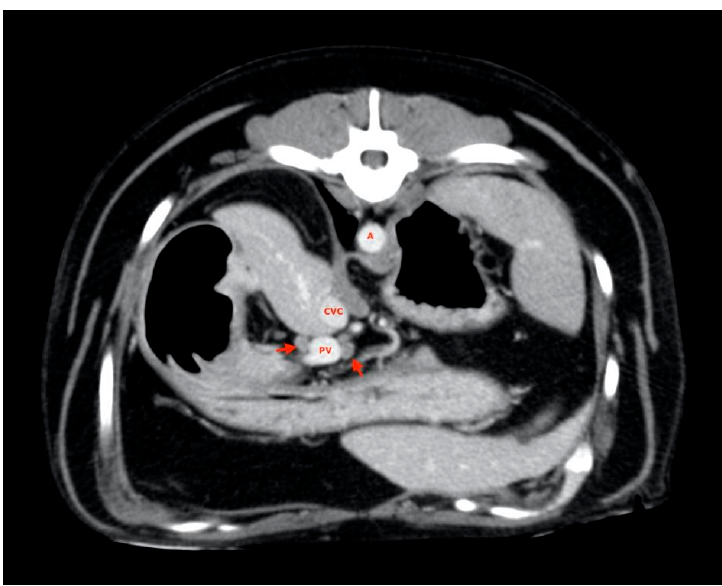
Figure 2. Hepatic lymph nodes (red arrow). A, aorta; CVC, caudal vena cava; PV, portal vein. Splenic lymph nodes were usually found along the dorsal margin of the splenic vein (Figure 3), and almost all of them were disposed with their major axis along the subject’s transverse plane rather than on the sagittal plane, as most ALs have been explored.